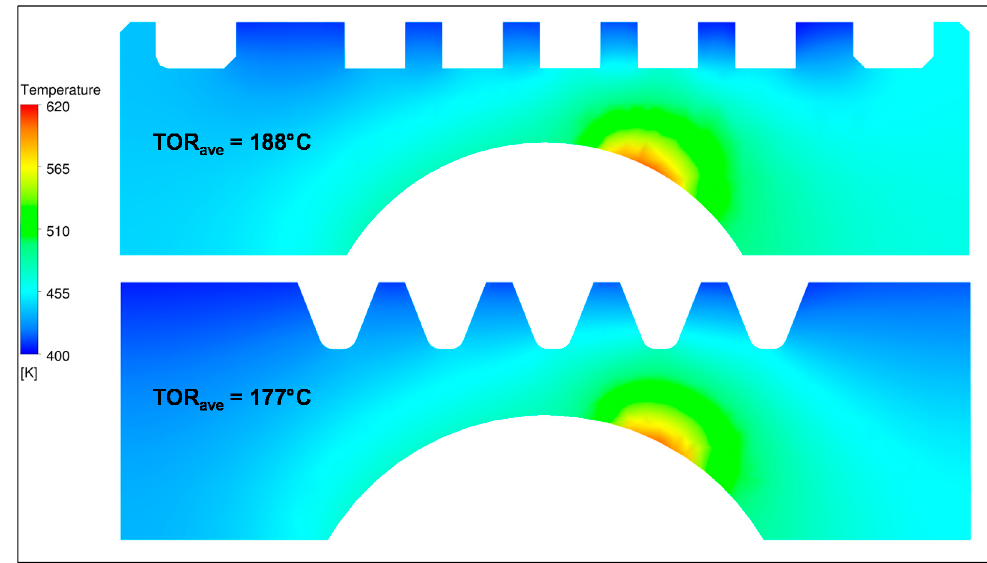
Figure 23. The average temperatures in the outer ring at 120 L/H oil flow and 80 °C oil temperature. In the first two fin rows the temperature gradient in the fin is 54 K.